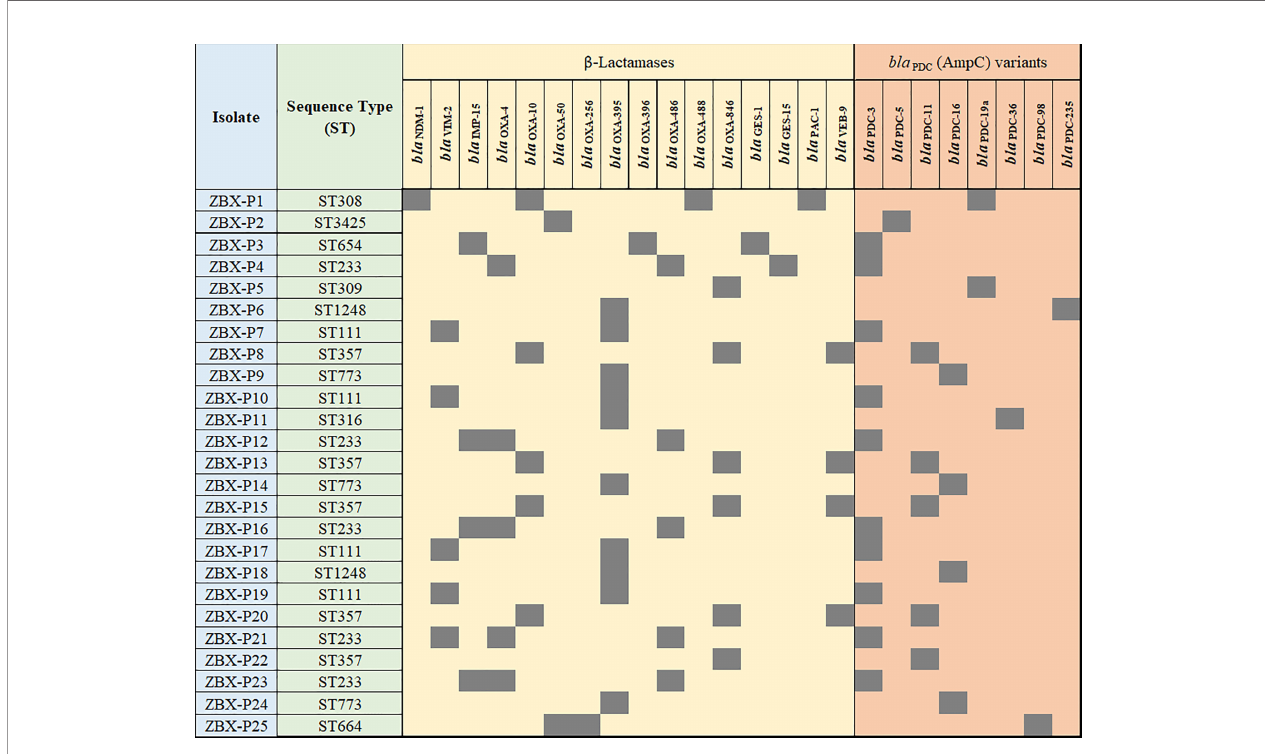
FIGURE 3 | Detailed phenotypic and genotypic resistance information of the C/T resistant P. aeruginosa isolates. ST, Sequence type. Classes of antibiotic resistance genes are marked as follows: aminoglycoside, phenicol, macrolide, tetracycline, fosfomycin, quinolone, rifampicin, trimethoprim, and sulphonamide resistance genes. MIC, Minimum inhibitory concentration (µg/ml), DD, Diffusion diameter (mm). Black,